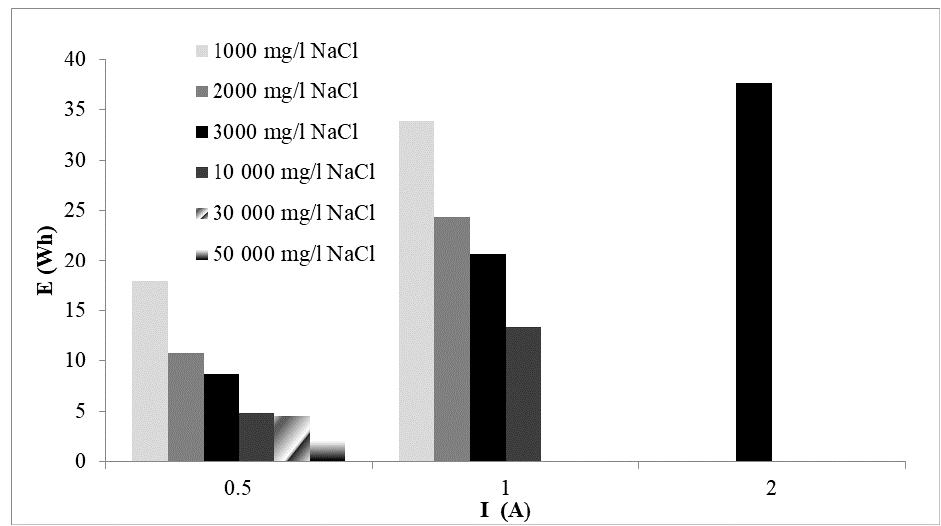
Figure 4. Dependence of EC energy consumption on current intensity and NaCl concentration. Volume = 350 mL, model solution, pH = 6.